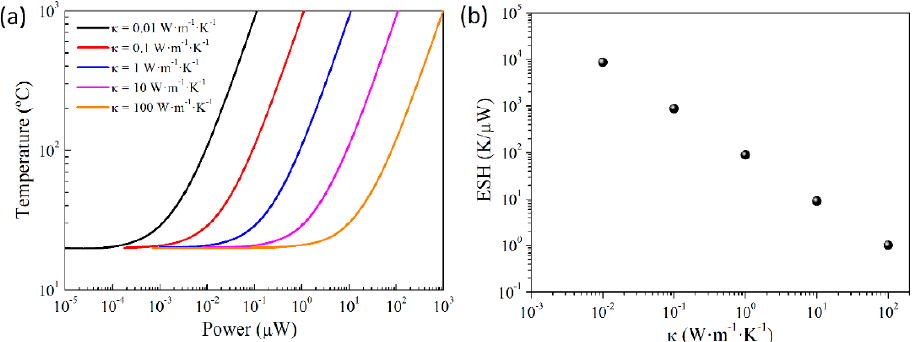
Figure 4. ( a ) Temperature reached at the center of the nanowire as function of the power dissipated with different thermal conductivities and ( b ) efficient self-heating coefficient (ESH) as a function of the thermal conductivity with a nanowire diameter of 60 nm and a electrical conductivity of σ = 100 S·m − 1 . Reproduced from Ref. [40], with permission from